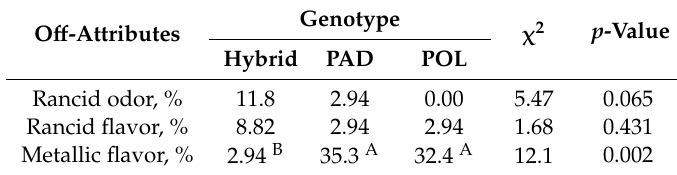
Table 5. Breast meat o ff -attributes’ prevalence according to genotype (Hybrid, PAD, POL). Genotype χ 2 p O ff -Attributes